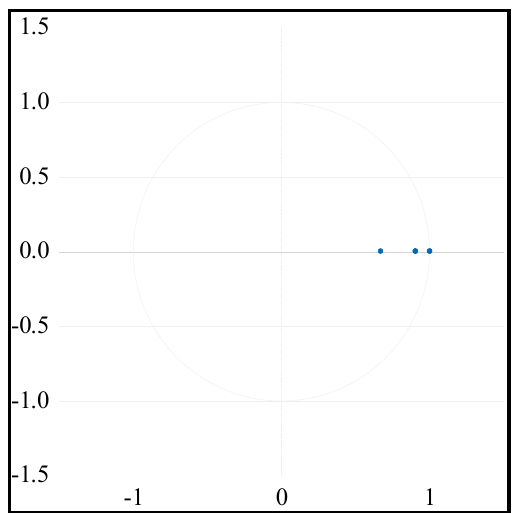
Figure 3. Stability of Vector Autoregressive Model.